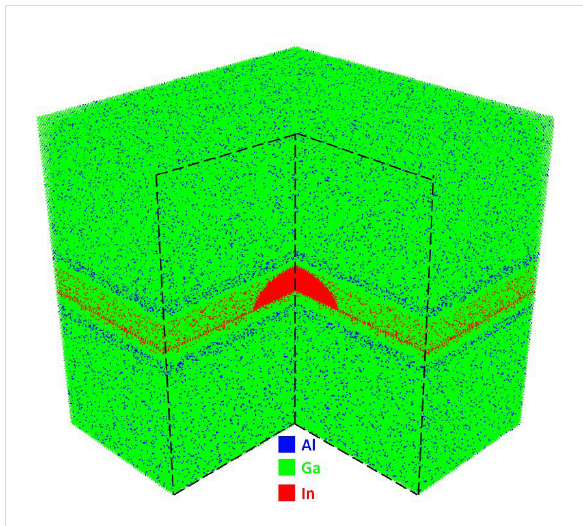
Figure 2: The atomistic grid of the simulated QD showing only cations (Al,Ga,In) to emphasize the randomness of the simulated alloys. The number of atoms used for the strain simulation is approximately 10 million atoms, while for band structure calculations only approximately 1.5 million atoms are used.